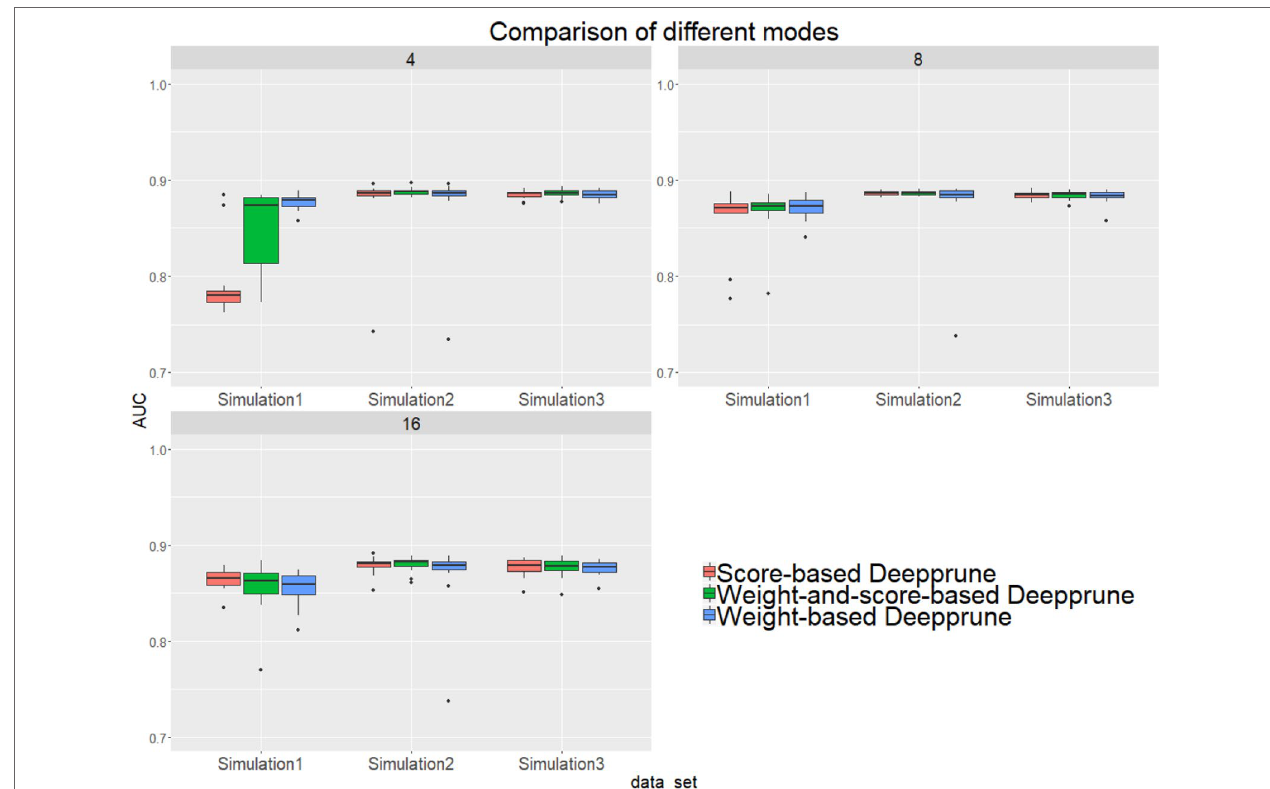
FIGURE 4 | Three models of Deepprune are compared on the simulated datasets. We show the performance of Deepprune based on different criteria with 4, 8, and 16 kernels. The performance of three different criteria is almost identical to that with 8 and 16 kernels during iterative pruning. However, the final model with four kernels shows that weighted-based Deepprune is superior to the other two methods in simulated dataset 1, but hard to classify owing to high entropy.